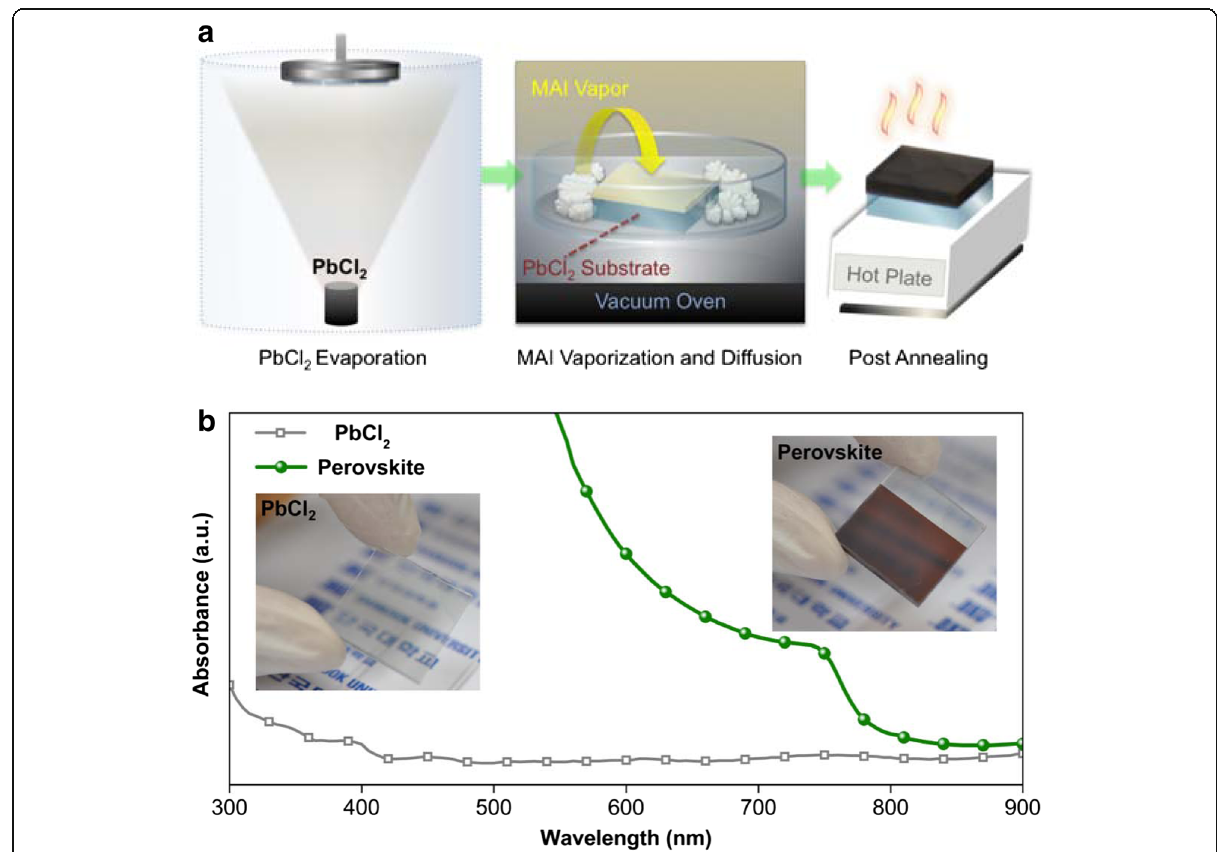
Fig. 1 a Schematic illustration of the fabrication process, via PbCl 2 evaporation, MAI vaporization and diffusion, and post-annealing. b UV-Vis absorption spectra of the PbCl 2 and perovskite layers. Corresponding sample photographs are given in